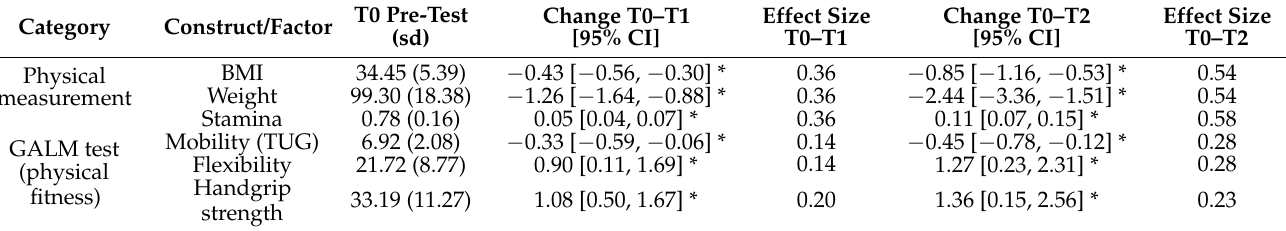
Table 2. Results of the physical measurements and GALM test.